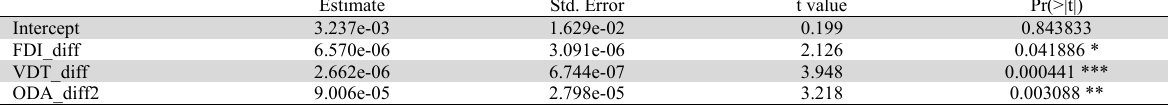
Regression results of the selected model include 3 independent variables FDI, ODA, VDT Estimate Std. Error